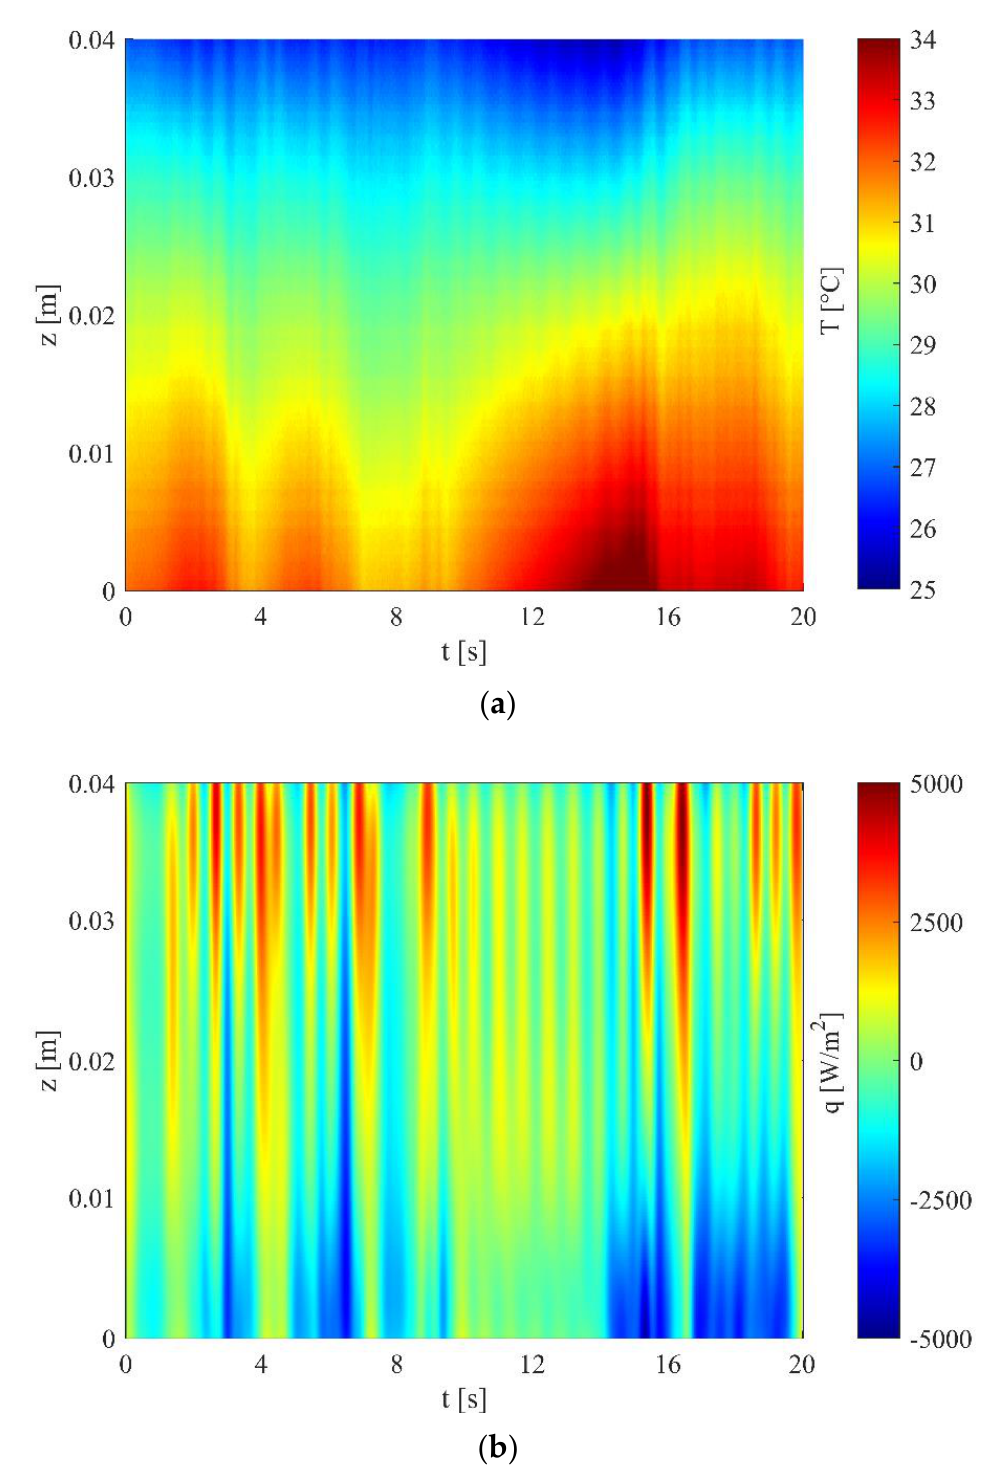
Figure 9. Space – time temperature distribution acquired by means of thermography ( a ) and resulting wall-to-fluid heat flux q ( b ); (channel 8, horizontal orientation, Q = 100 W).